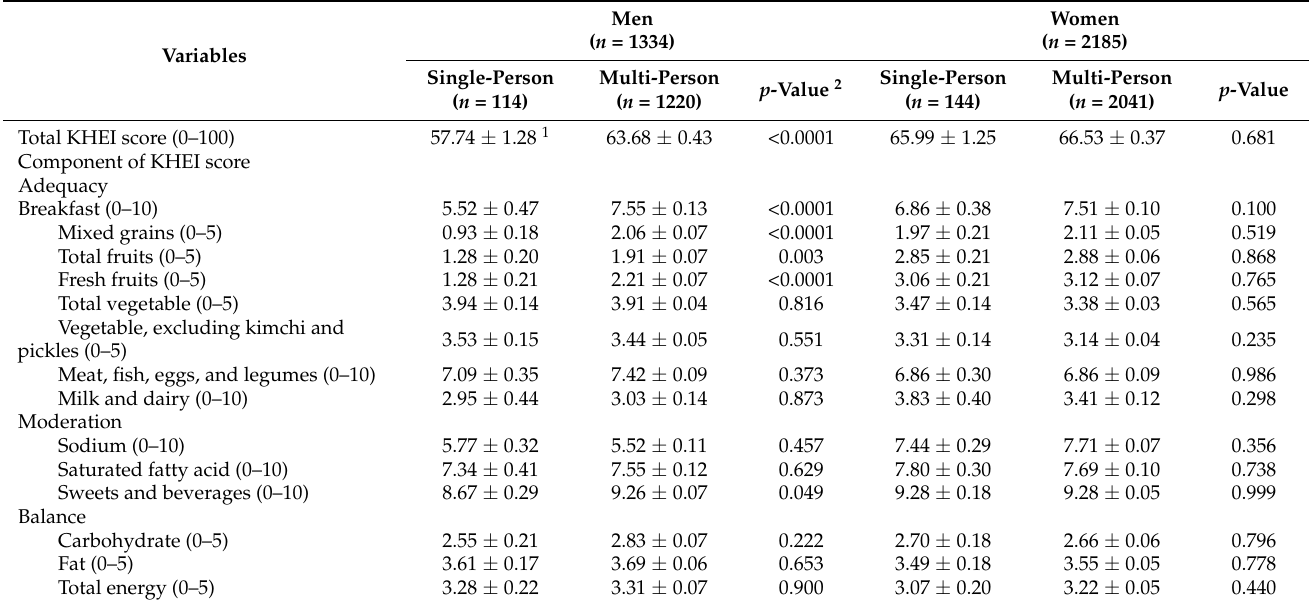
Table 4. Korean Healthy Eating Index (KHEI) score of participants according to household size by